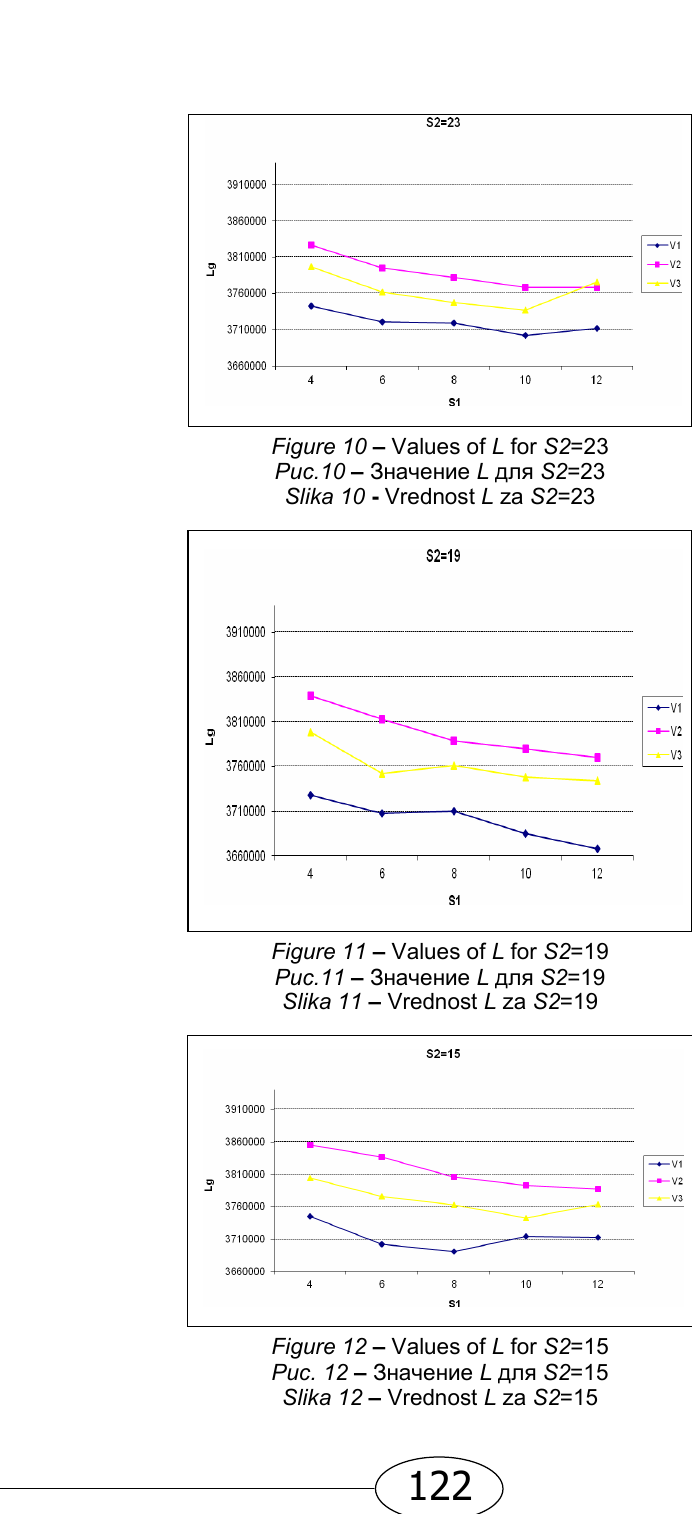
Figure 12 – Values of L for S2 =15 Рис . 12 – Значение L для S2 =15 Slika 12 – Vrednost L za S2